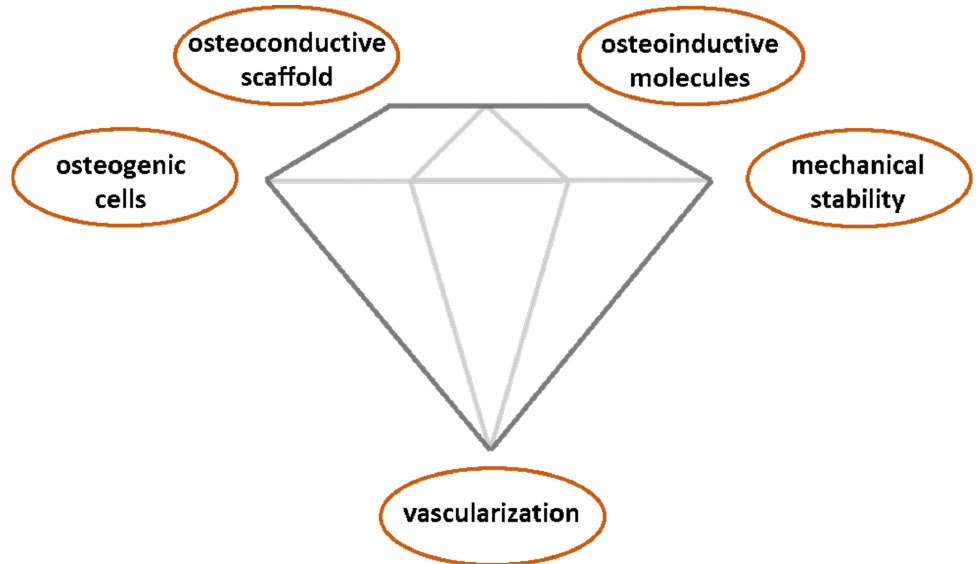
Figure 1. Schematic illustration of the diamond concept, showing the five elements that an ideal bone tissue engineering construct should provide.